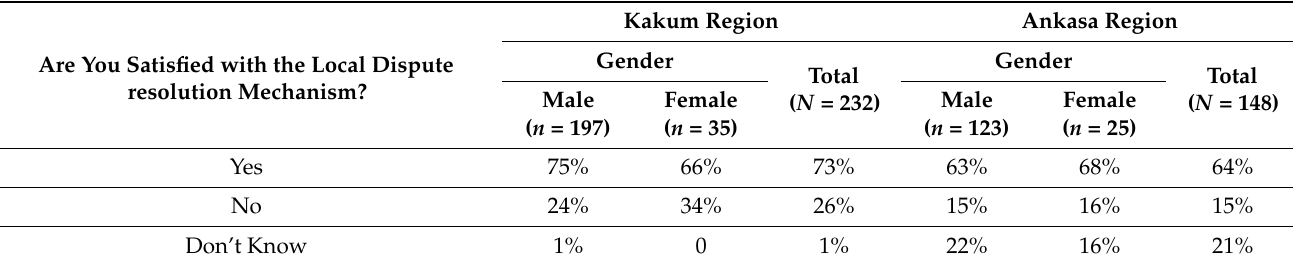
Table 5. Satisfaction with local dispute resolution mechanisms by